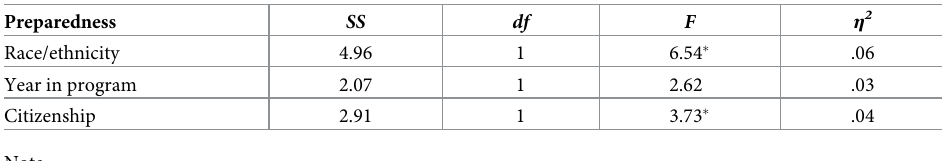
Table 4. RDM preparedness by participants’ personal